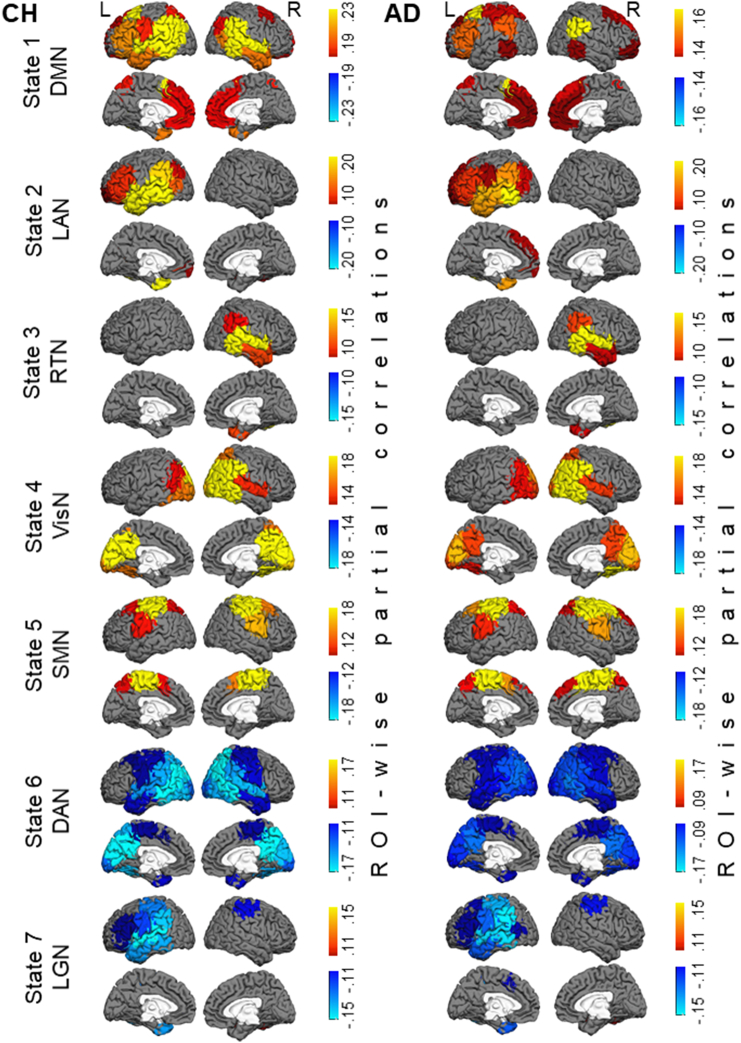
Maps of state-specific increases (in yellow/red/brown colors) and decreases (in blue color) in oscillatory amplitudes during seven salient network states inferred by the HMM. Each map shows partial correlations between the state time-course and the oscillatory amplitude envelopes in a priori ROIs. Maps in the CH group are shown in the left panel and in the AD group in the right panel. Note, for States 1 & 6, the maps are shown using different color scales for the CH and AD groups to optimally illustrate the network topography in each group. Abbreviations: CH, cognitively healthy, AD, Alzheimer's disease, DMN, default mode network, LAN, left associative network, RTN, right temporal network, VisN, visual network, SMN, sensorimotor network, DAN, dorsal attention network, LGN, language network.